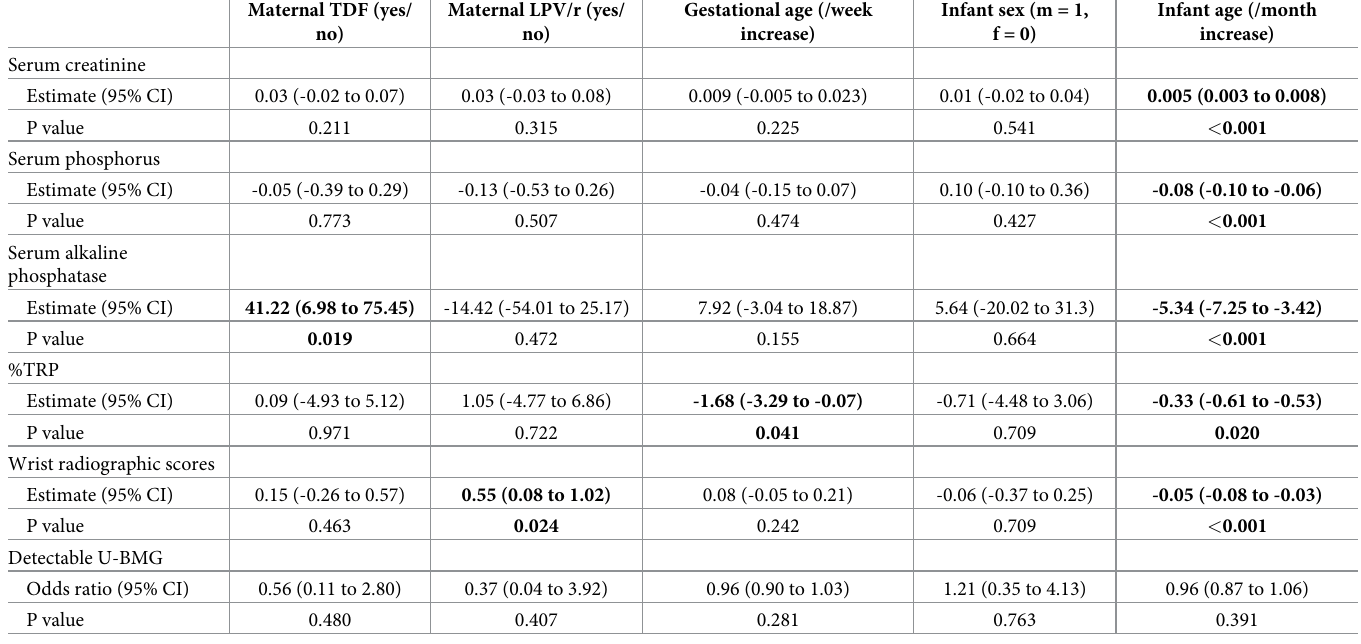
Table 4. Results of multivariate regression analysis of the association of various laboratory findings with maternal and infant